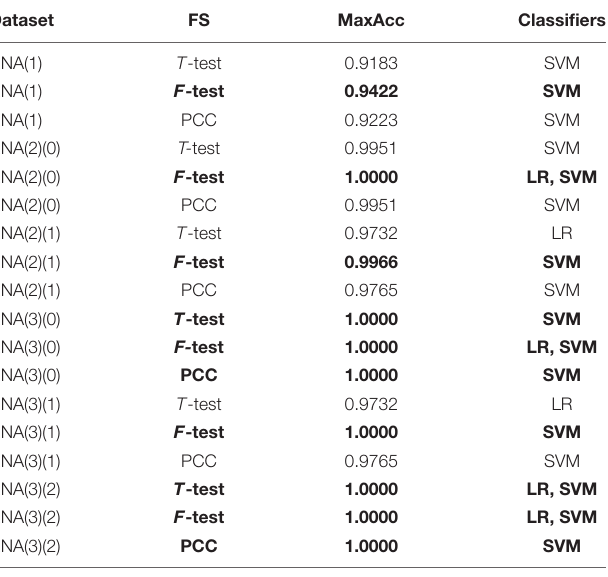
TABLE 4 | Summary of whether each classifier achieved the best classification accuracy on the 19 feature subsets of each dataset. Dataset FS